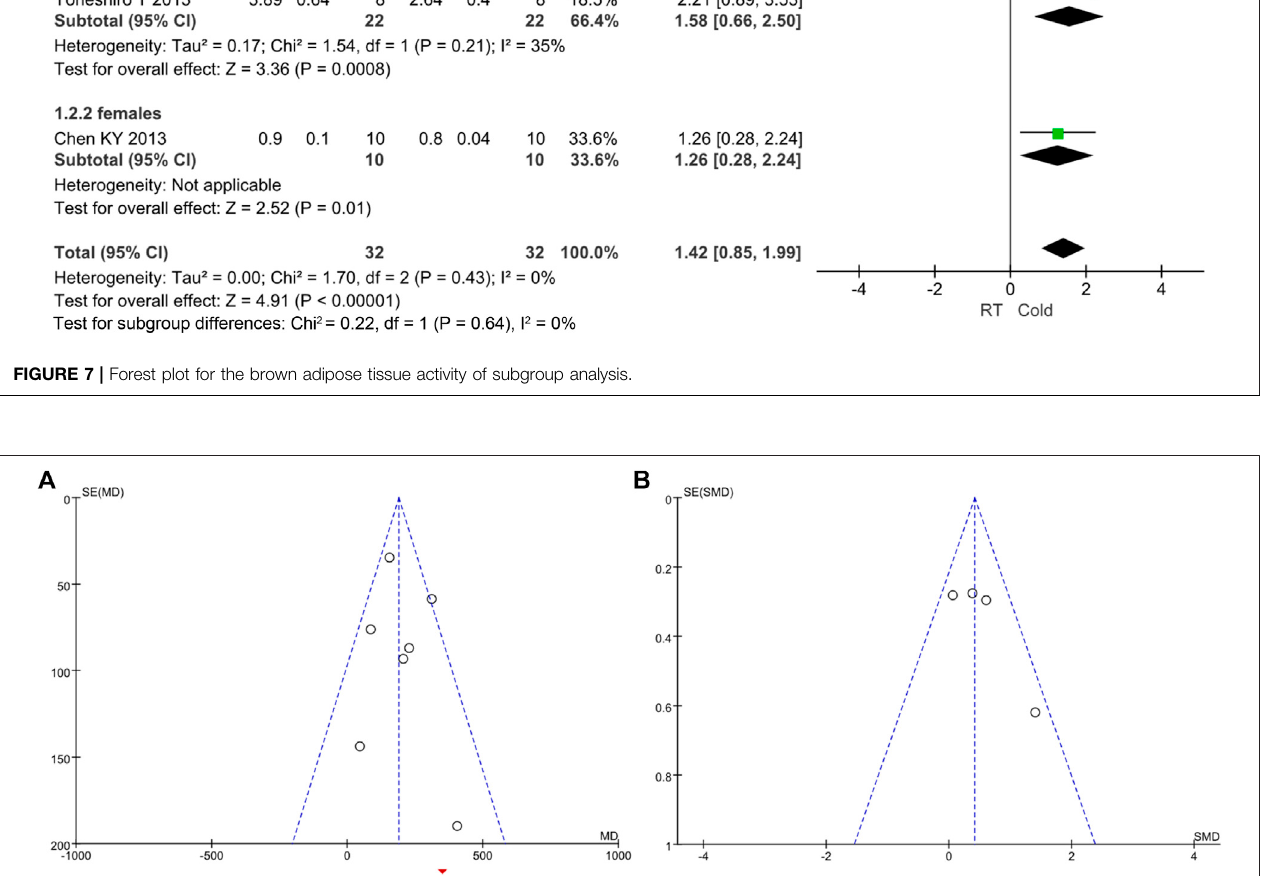
FIGURE 8 | Funnel plots of RCTs recording energy expenditure (A) and BAT volume (B) outcomes.